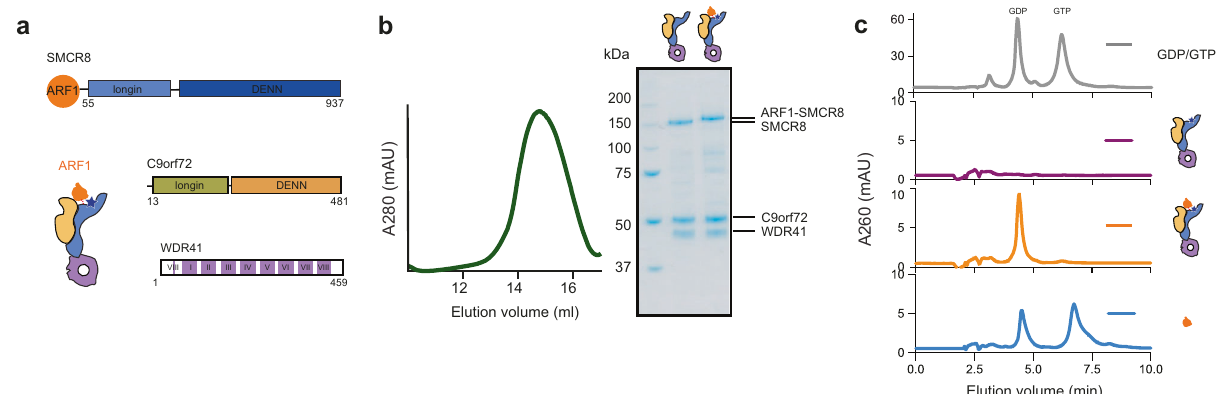
Fig. 1 Construct design of C9orf72:ARF1-SMCR8:WDR41 complex. a Diagram of the complex design. ARF1 is fused to the N-terminus of SMCR8 subunit. The blue star represents the position of the catalytic Arg residue of SMCR8. b Left, the Superose 6 size exclusion pro fi le of the reconstituted ARF1-SMCR8: C9orf72:WDR41 complex. Right, the SDS-PAGE analysis of the peak fractions for ARF1-SMCR8:C9orf72:WDR41 complex compared with wild-type complex. c The HPLC analysis of the puri fi ed C9orf72:SMCR8:WDR41, C9orf72:ARF1-SMCR8:WDR41 complex, and ARF1. The elution pro fi le for GDP/GTP is shown on the